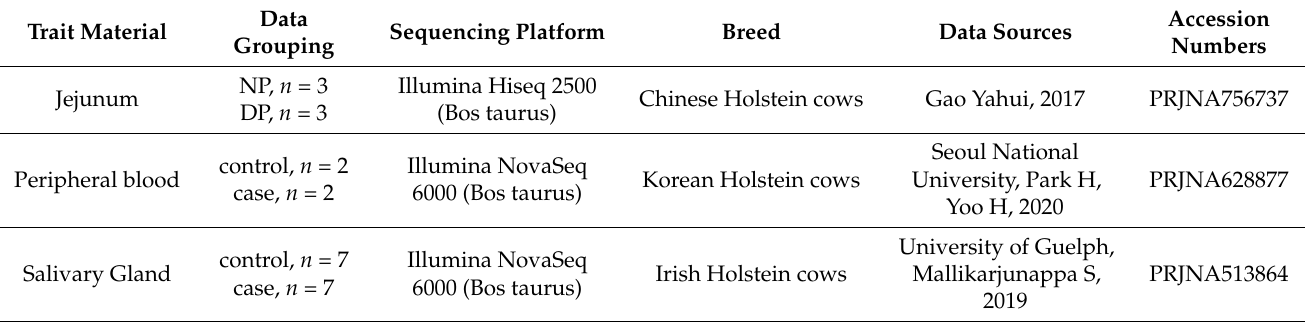
Table 1. Detailed information about the RNA-seq